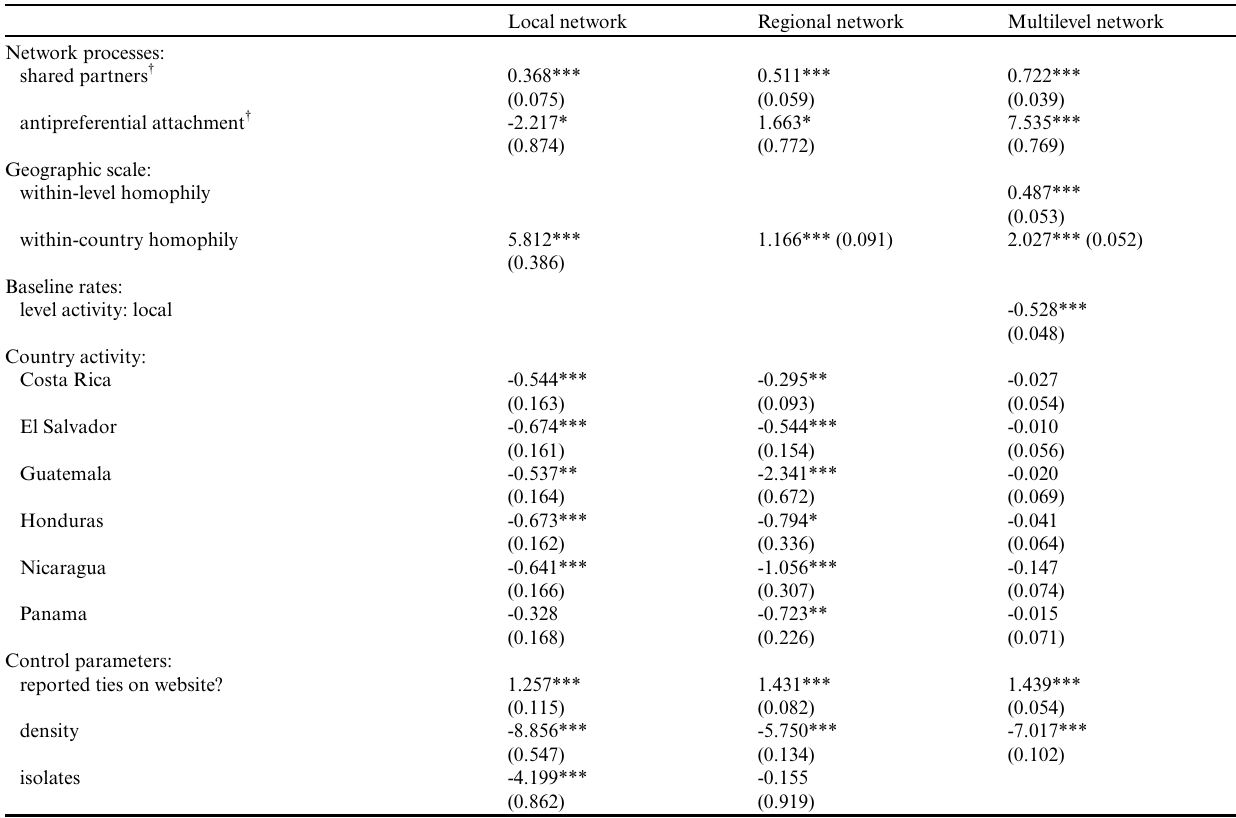
Table 2 . Exponential random graph models (ERGMs) for the local, regional, and multilevel governance